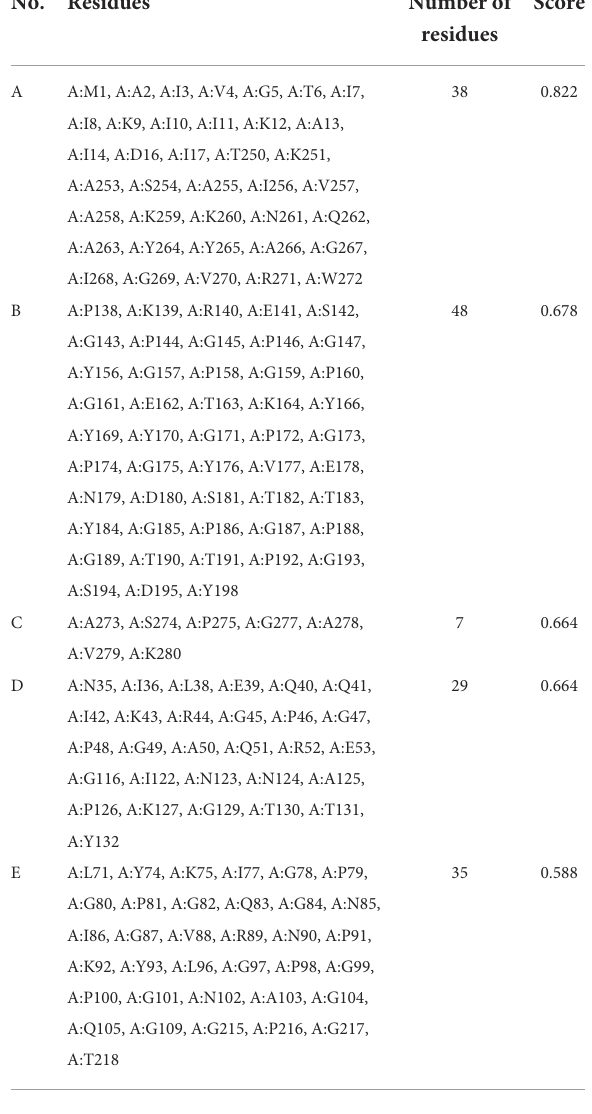
TABLE 3 Discontinuous B-cell epitopes of vaccine constructs predicted by ElliPro. No. Residues Number of Score